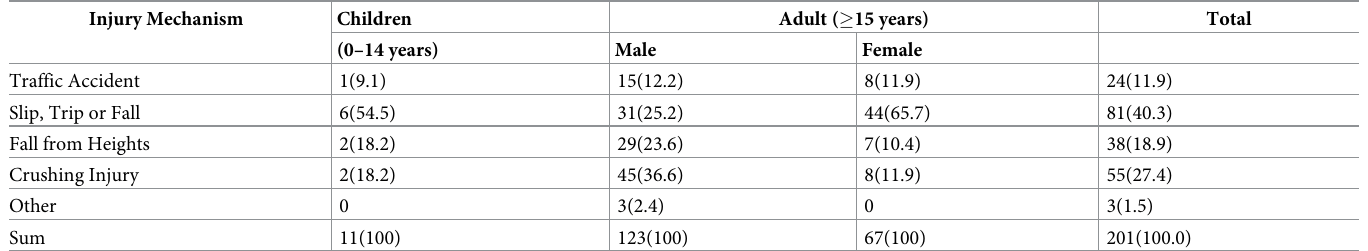
Table 2. The causal mechanisms for foot fractures in China in 2014 (n, %).